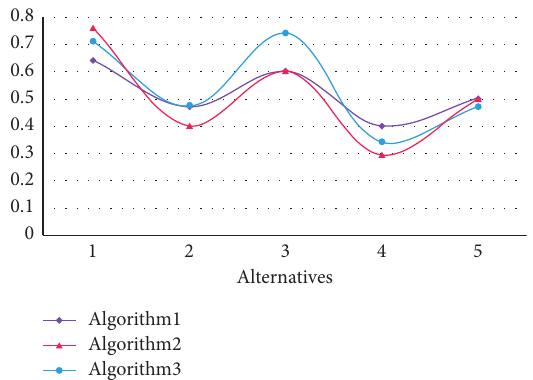
Figure 1: Comparisons of the ranking results in Example 21 based on Algorithms